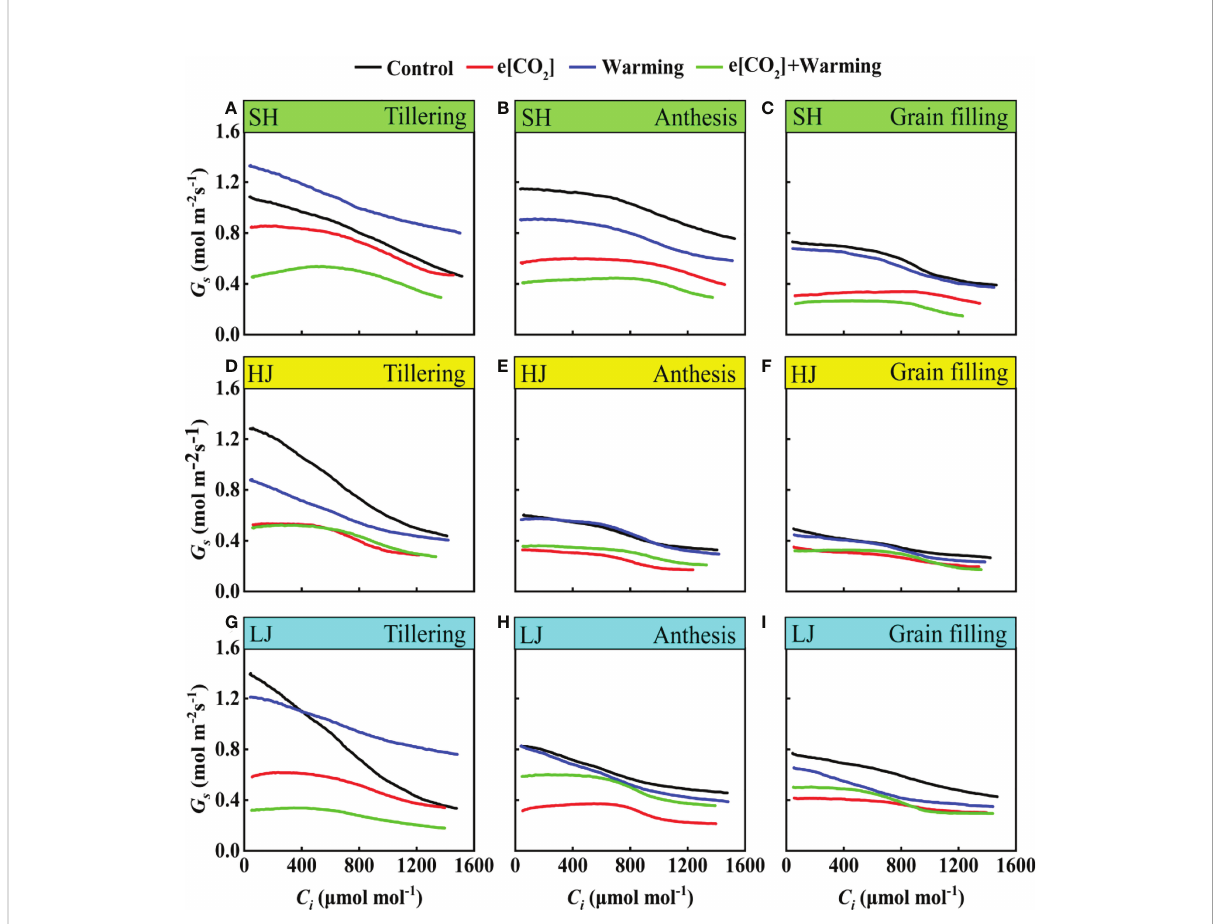
FIGURE 7 The G s - C i Curves under ambient CO 2 and temperature (black dots, Control), elevated CO 2 concentration (red dots, e[CO 2 ]), elevated temperature (blue dots, warming), and elevated CO 2 concentration plus warming (green dot, e[CO 2 ] + warming) for cv. SH ( A-C ), HJ ( D-F ), and LJ (G, H, I) during the tillering stage, anthesis stage, and grain- fi lling stage. G s represents stomatal conductance, C i represents intercellular carbon dioxide